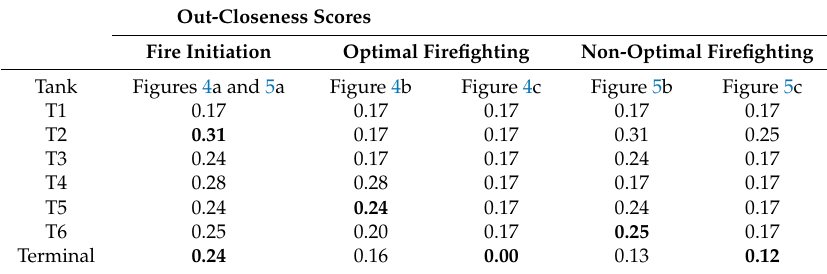
Figure 5. Non-optimal firefighting strategy for Scenario 2. ( a ) T1, T2, and T4 are all on fire. ( b ) T1 and T2 are on fire, and T4 is suppressed. ( c ) T1 and T2 are on fire, T4 is suppressed, and T6 is cooled. Table 2. Tanks’ and terminal’s out-closeness scores for the graphs in Figures 4 and 5. Table 2. Tanks’ and terminal’s out -closeness scores for the graphs in Figures 4 and 5.